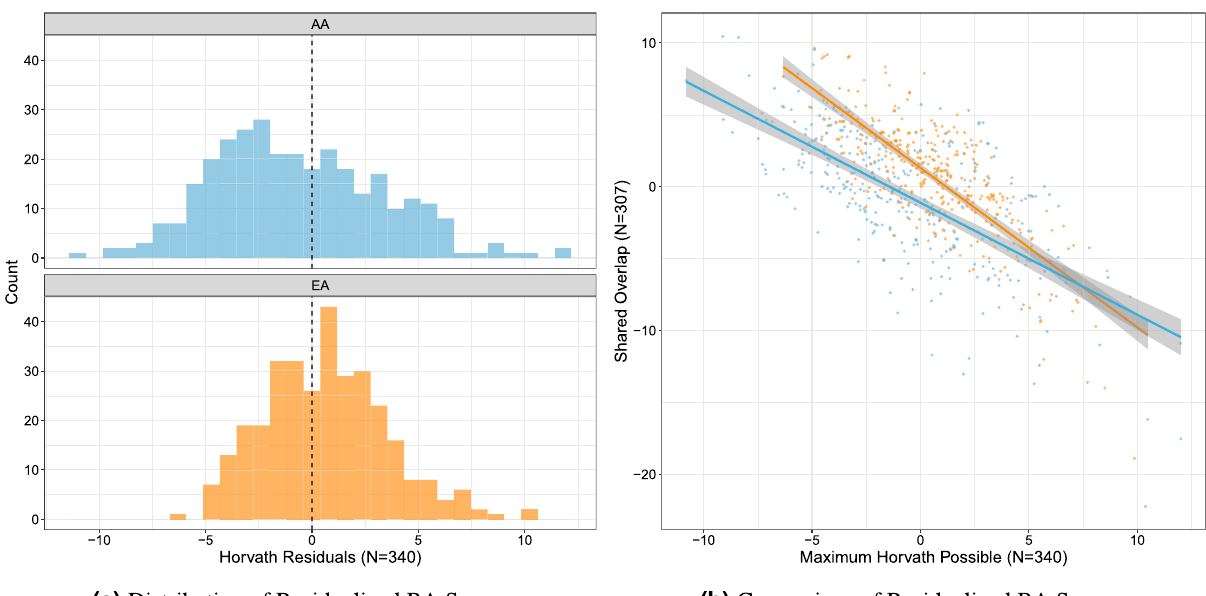
Figure 3. Residualized biological age scores were calculated by regressing chronological age on biological age (BA). ( a ) The distribution of residualized BA scores by self-reported Census-based race category (AA = African American, EA = European American). ( b ) Comparison of residualized BA scores calculated from the largest possible Horvath probe subset and the probe subset shared between PREG and replication cohort GAPPS ( orange = EA , blue = AA